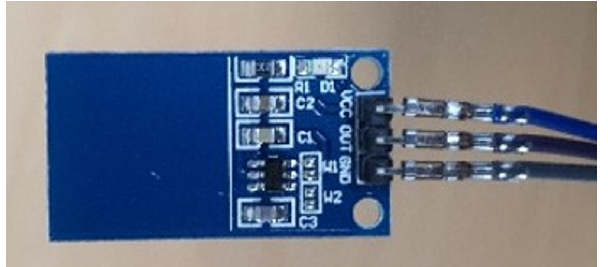
Figure 1. A capacitive sensor.